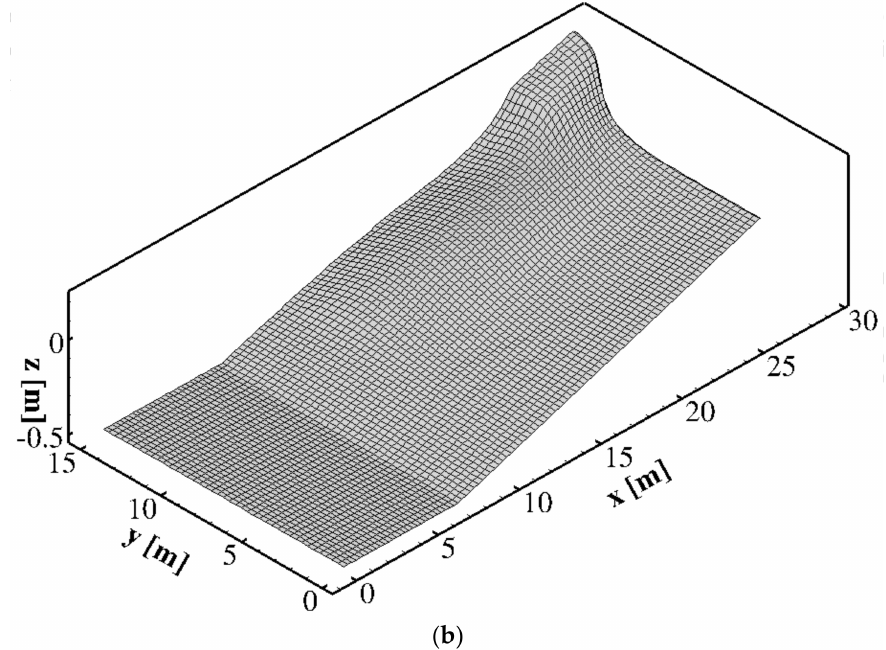
Figure 1. ( a ): Plan view of the curvilinear computational grid (Only one out of every five coordinate lines is shown). ( b ): three-dimensional view of the bottom.